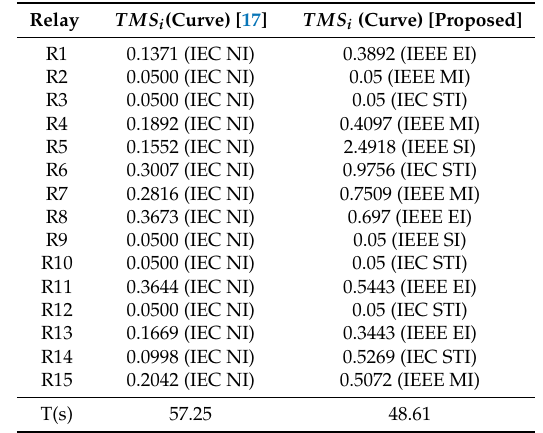
Table 12. Coordination parameters considering all OMs simultaneously.